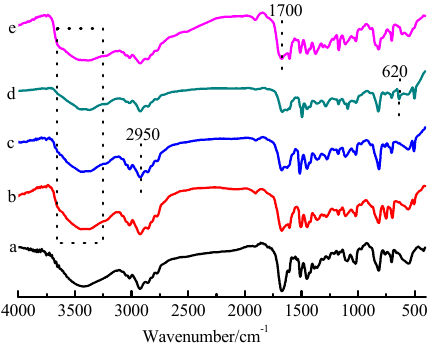
Figure 10. FTIR spectra of the CDM-HCP before and after metal adsorption: CDM-HCP ( a ), CDM-HCP-aniline ( b ), CDM-HCP- p -MA ( c ), CDM-HCP- p -CA ( d ), and CDM-HCP- p -ABC ( e ).